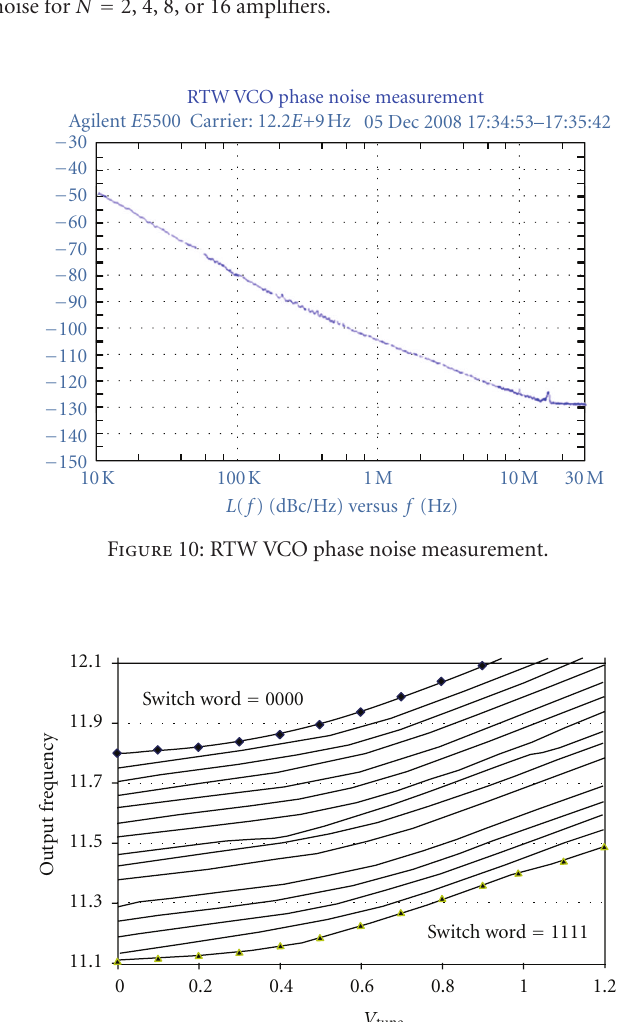
Figure 7: ISF functions and phase noise for N = 2, 4, 8, or 16 amplifiers.